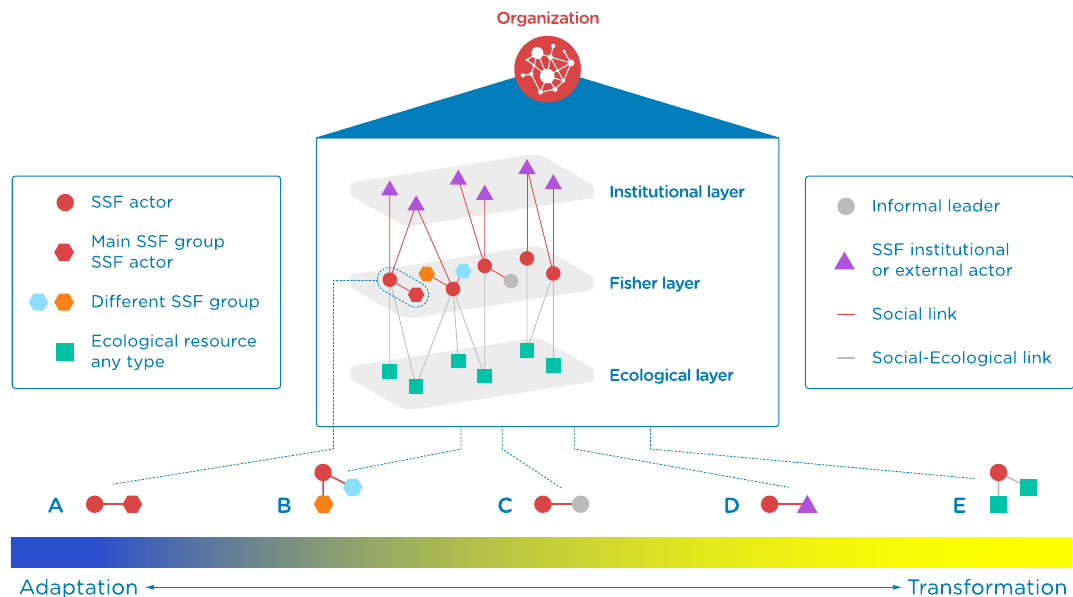
Figure 1. Social and social-ecological network structures hypothesized to support adaptation and transformation. Graphical representation of the social ties that fishers develop with other social actors, such as trust and/or communication (red line), and the social-ecological ties fishers develop with ecological resources (grey line). Ties occur across three layers: (1) institutional layer (with institutional actors represented in triangles); (2) fisher layer (where individuals are represented in circles and fisher groups in hexagons); and (3) ecological layer (with ecological resources represented in squares). These links result in the ( A – E ) specific social and social-ecological network structures hypothesized to support adaptation and transformation that we test here, adapted from those in 11 . ( A ) Structure A captures the concept of bonding ties between a fisher (red circle) and the main fishing group the fisher belongs to (red hexagon). ( B ) Structure B depicts bridging ties between a fisher and different fishing groups (yellow and blue hexagons). ( C ) Structure C represents a link between a fisher and informal leaders within their fishing community (grey circle). ( D ) Structure D represents a link between a fisher and institutional actors, such as technical advisors or fishing guards (purple triangles), which are often referred to as linking ties 7 . ( E ) Structure E represents the link between a fisher and their main marine target resources (green squares). On the bottom, the figure illustrates the expected adaptation-transformation continuum based on a recently developed social-structural theory of adaptive behaviour 7 . This gradient shows how organizational structures can predispose individuals to adaptation and/or transformation